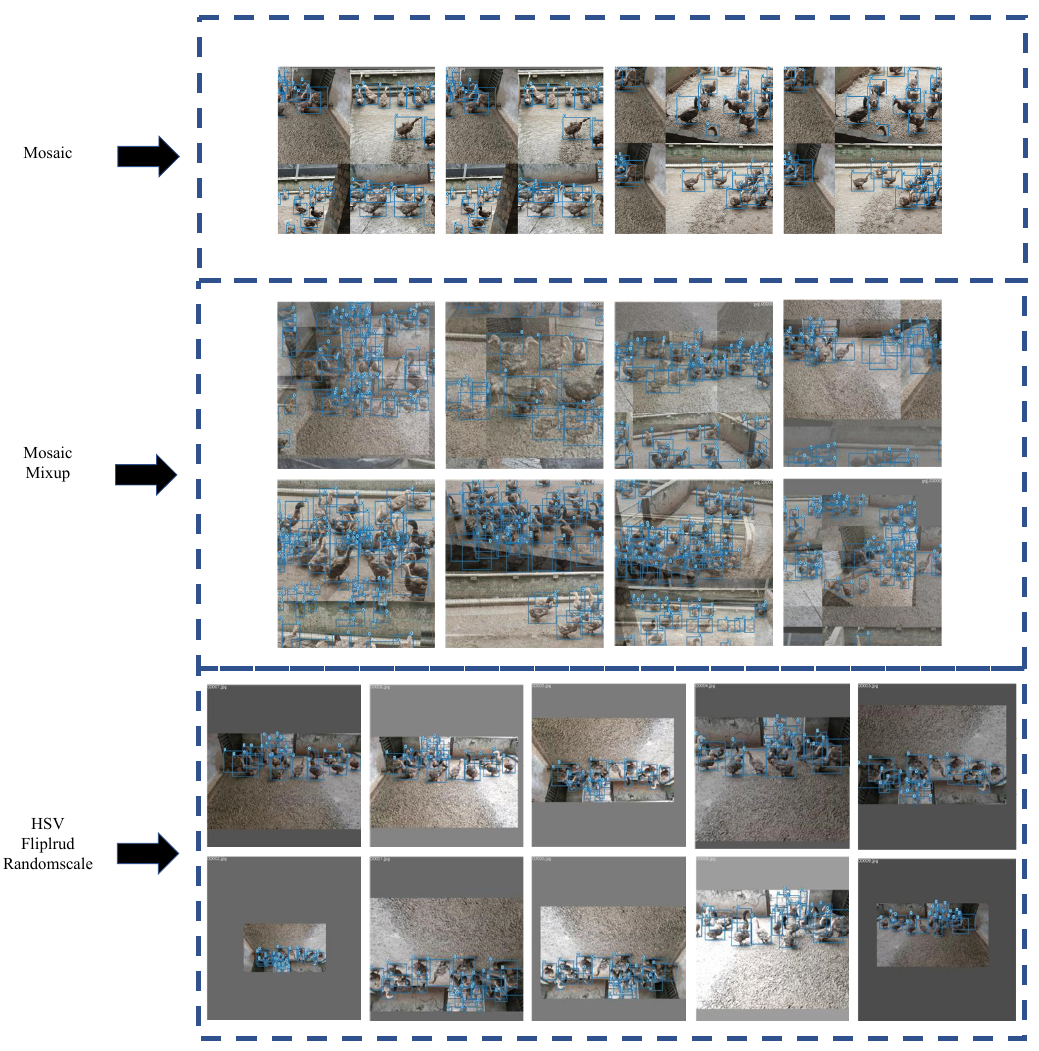
Figure 4. Images after data enhancement. (1) Mosaic: Images enhanced by Mosaic data enhancement. Four images are selected randomly, scaled and cropped randomly, and then stitched together in random order. (2) Mosaic and Mixup: Images after Mosaic and Mixup enhancement. First, any four images are scaled and stitched together. Next, two random samples are mixed proportionally, and the results of the classification are assigned proportionally. (3) HSV, Fliplrud, and Randomscale: Images after HSV, Fliplrud, Randomscale. Images are randomly flipped and scaled with a probability of 50%. At the same time, the hue, saturation, and value of the images are